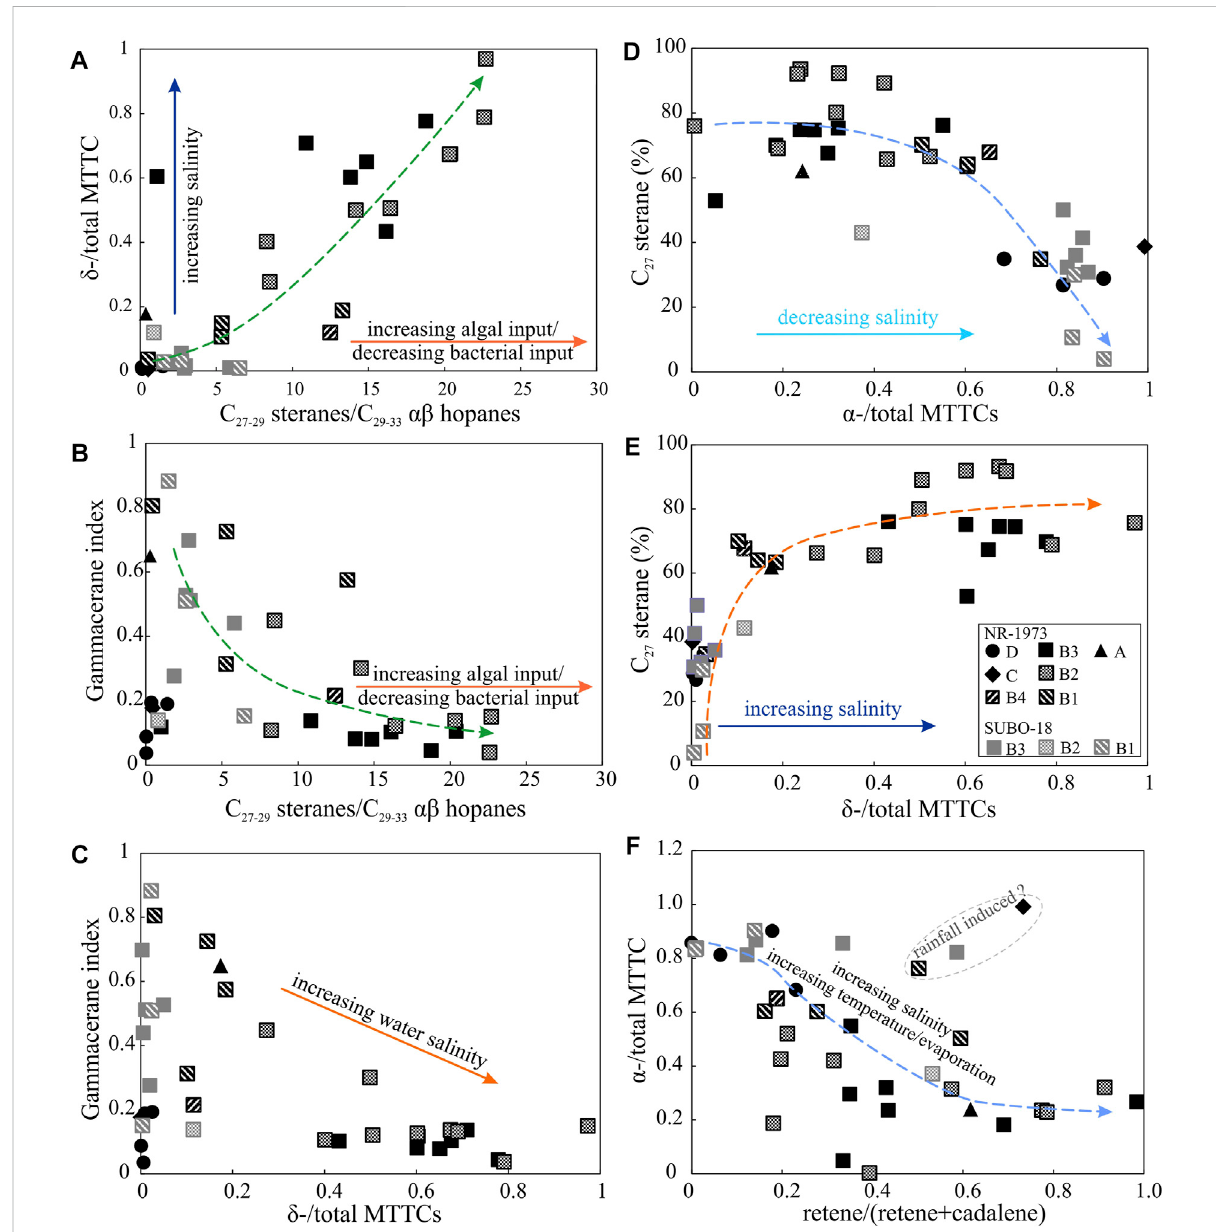
FIGURE 12 Relations between paleo-climate, water salinities and bio-communities. (A) δ -/total MTTC vs C 27-29 steranes/C 29-33 αβ hopanes, (B) gammacerane index (gammacerane/(gammacerane+C discussion of these biomarker ratios. See Figure 2 for stratigraphic